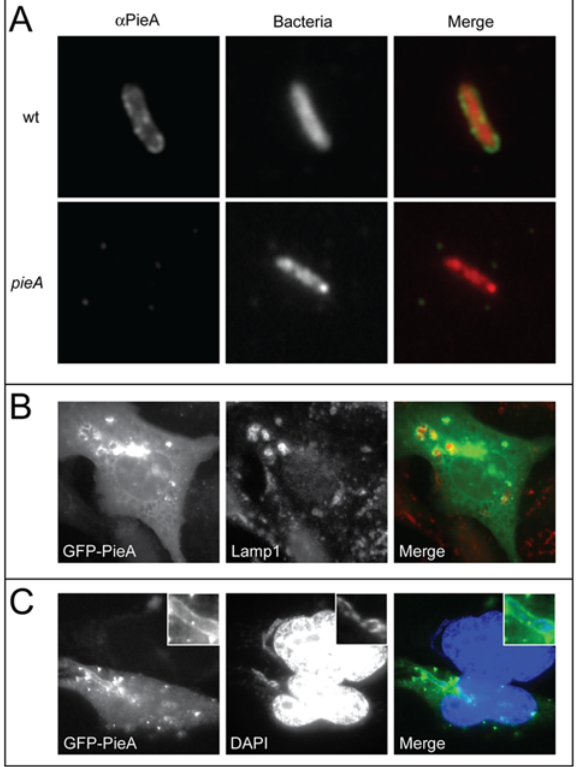
Figure 3. PieA associates with vacuoles containing L.pneumo- phila . (A) Representative epifluorescence micrographs of L. pneumo- phila vacuoles isolated from U937 macrophage-like cells infected with bacteria expressing the fluorescent protein DsRed. Endogenous PieA was detected on vacuoles isolated from cells infected with wild-type L. pneumophila using a PieA-specific antibody and FITC-labeled secondary antibodies. No PieA staining was detected on vacuoles from cells infected with a pieA mutant strain. CHO Fc c RII cells transiently expressing the fusion protein GFP-PieA were (B) fixed and stained for the lysosomal marker LAMP-1, revealing GFP-PieA staining in regions of clustered lysosomes, or (C) infected with wild-type L. pneumophila for seven hours, and stained with DAPI to identify bacterial DNA and host cell nuclei. Vacuoles containing L. pneumophila are magnified in the inset of each image. GFP-PieA was observed in association with vacuoles containing L. pneumophila .